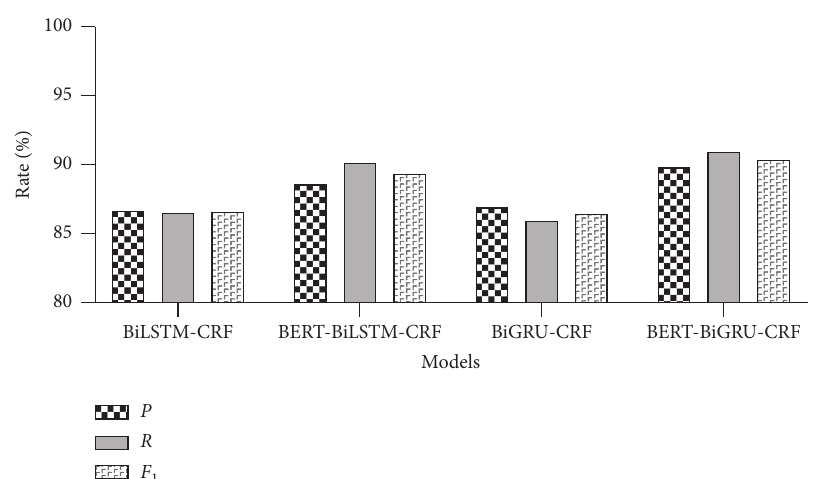
Figure 5: Comparison of various indicators of different models.